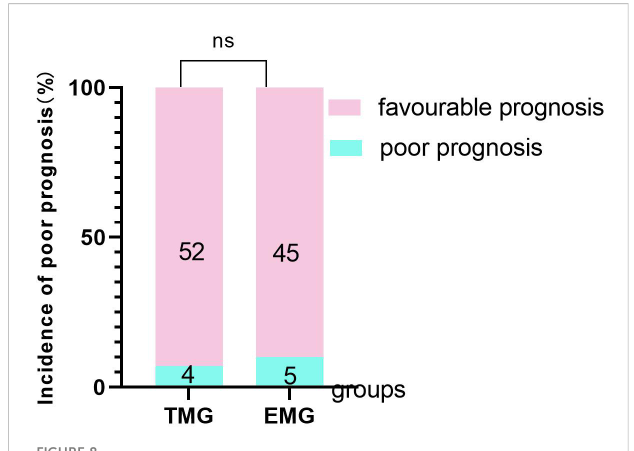
FIGURE 8 The comparison of the incidence of poor prognosis between the two groups. TMG, Targeted medication group; EMG, Empirical medication